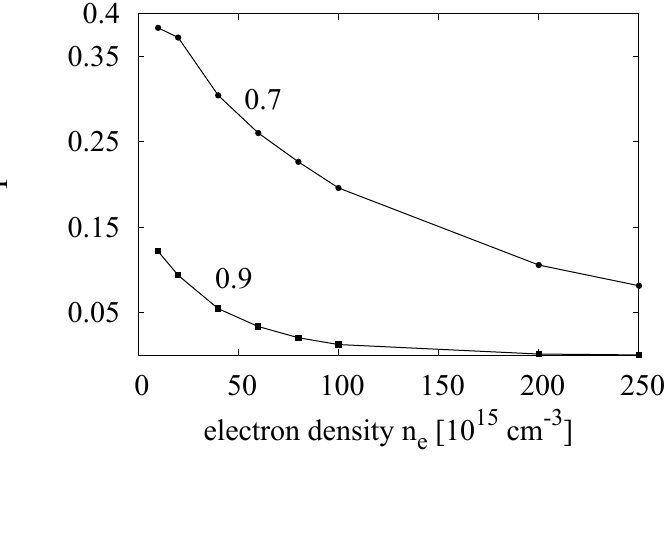
Figure 9. The integral, I , versus electron density at T = 300 K for two different values of σ ∗ , 0 . 7 and 0 . 9 , as